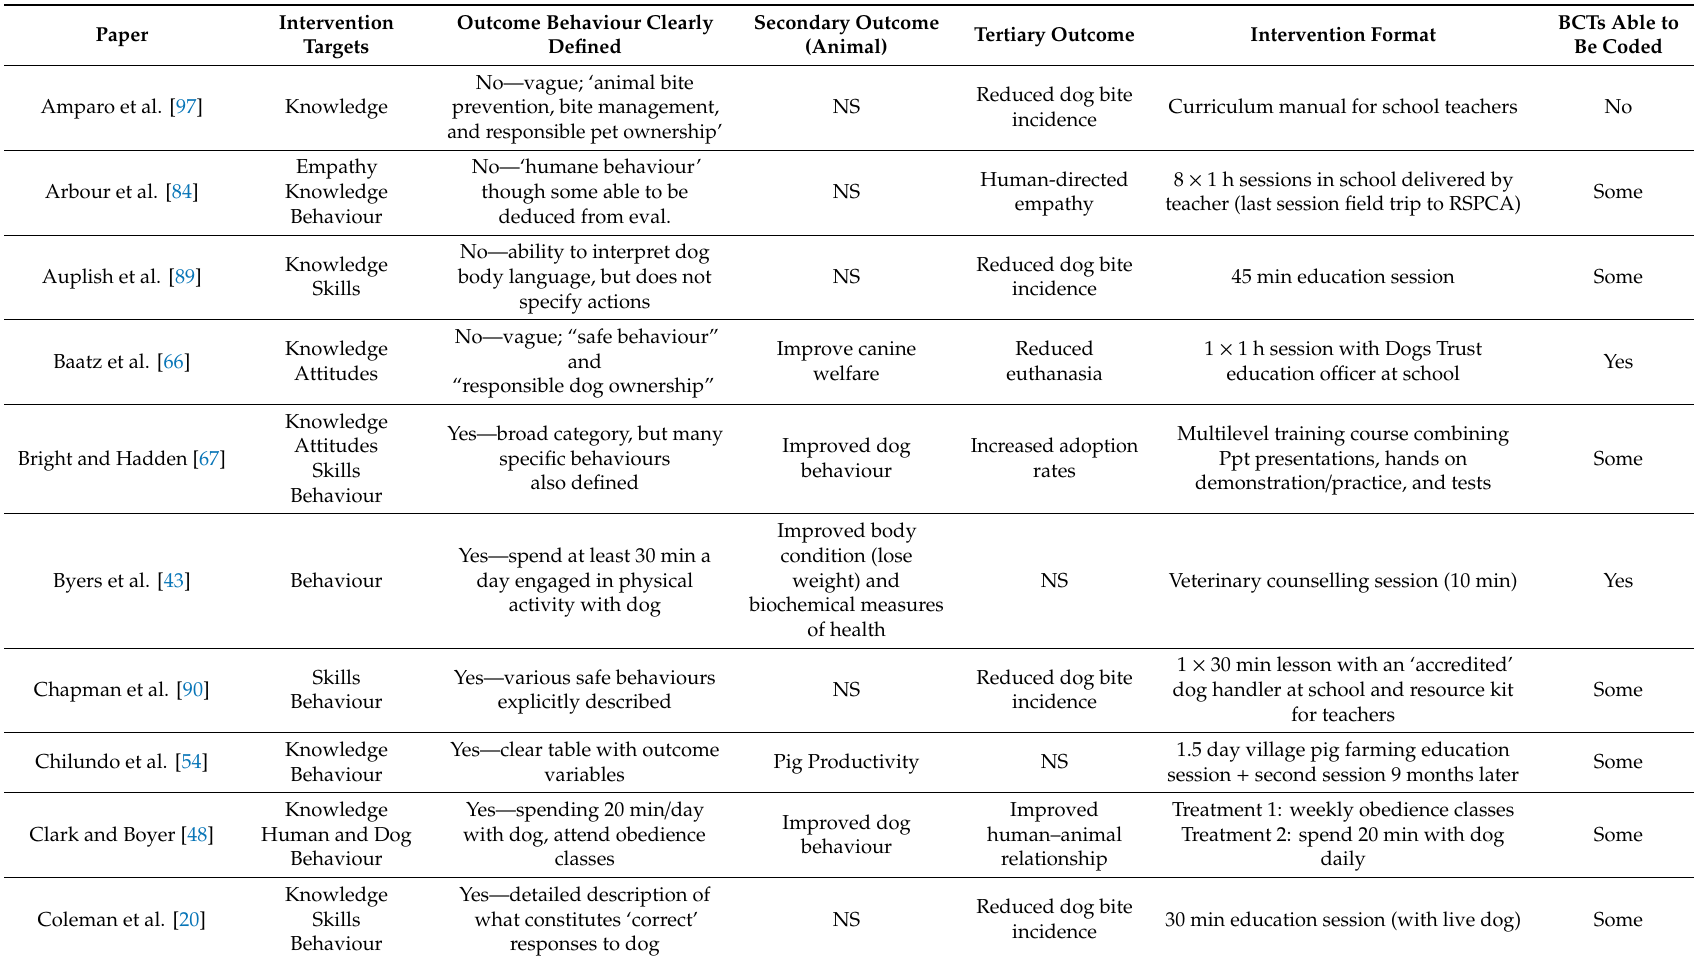
Table A2. Intervention targets and